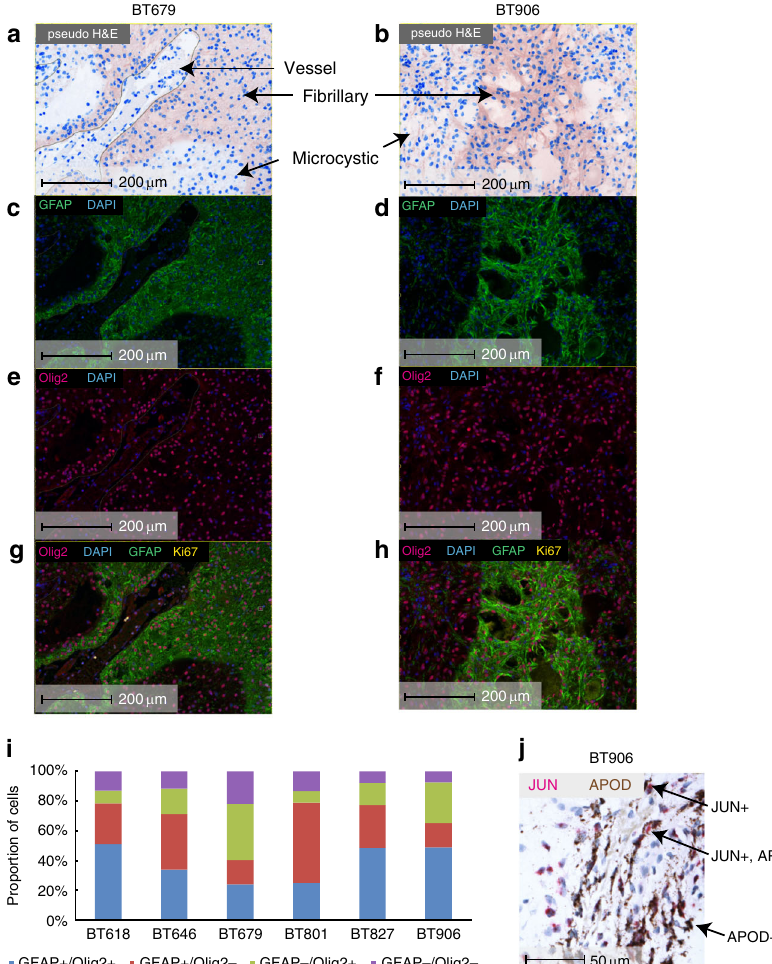
Fig. 6 Compartment-speci fi c expression of PA genes. Representative images are shown for F-IHC analysis of BT679 ( a , c , e , g ) and BT906 ( b , d , f , h ). a – b Pseudo H&E staining. Microcystic and fi brillary components of PA biphasic histology are called out by arrows for both tumors. A vessel is called out as a negative control for tumor cells in BT906. c – d GFAP F-IHC, with GFAP positivity indicated in green. e – f Olig2 F-IHC is shown with Olig2 positivity indicated in red. g – h Overlay of Olig2 and GFAP F-IHC. Rare Ki67 positive cells are also shown in yellow. A blood vessel is outlined in the bottom left of the BT906 panels ( b , d , f , h ). i Quanti fi cation of Olig2 + and of GFAP + cells for six tumors. n = 14158 cells were analyzed for BT618; n = 22443 for BT646; n = 17234 for BT679; n = 5678 for BT801; n = 12674 for BT827; n = 12696 for BT906. j Representative image of RNA in situ hybridization of PA formalin- fi xed paraf fi n-embedded tissue from BT906 showing expression of a top gene in the MAPK signaling gene programme ( JUN ) and of a top gene in the astrocyte-like gene programme ( APOD ). Source data are provided as a Source Data fi